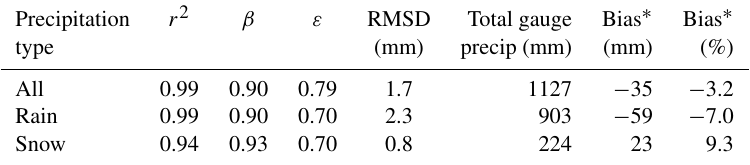
Table 1. Summary statistics for the comparison of geolysimeter estimated precipitation event amounts to corresponding gauge precipitation event amounts at the Duck Lake site. Gauge precipitation observations are considered to be the independent variable where β is the slope and ε is the intercept of the regression line. Bias is the gauge precipitation subtracted from (mm) or divided by (%) the geolysimeter precipitation. Precipitation r 2 β